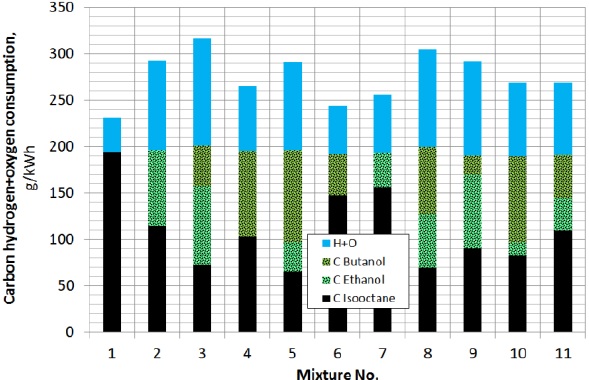
Fig. 5. BSFC min with carbon contents and it’s overcoming depends of blends